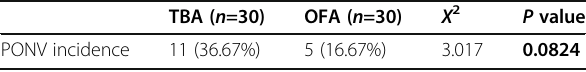
Table 4 Comparison between groups as regards